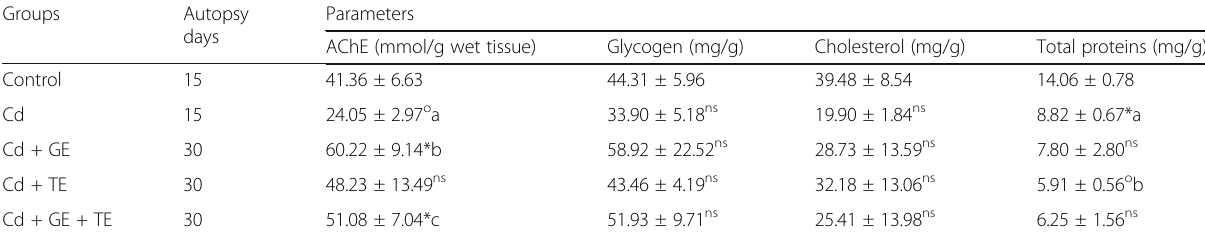
Table 2 Therapeutic effects of garlic and tomato against cadmium (Cd) induced biochemical parameters in mice at 30 days Groups